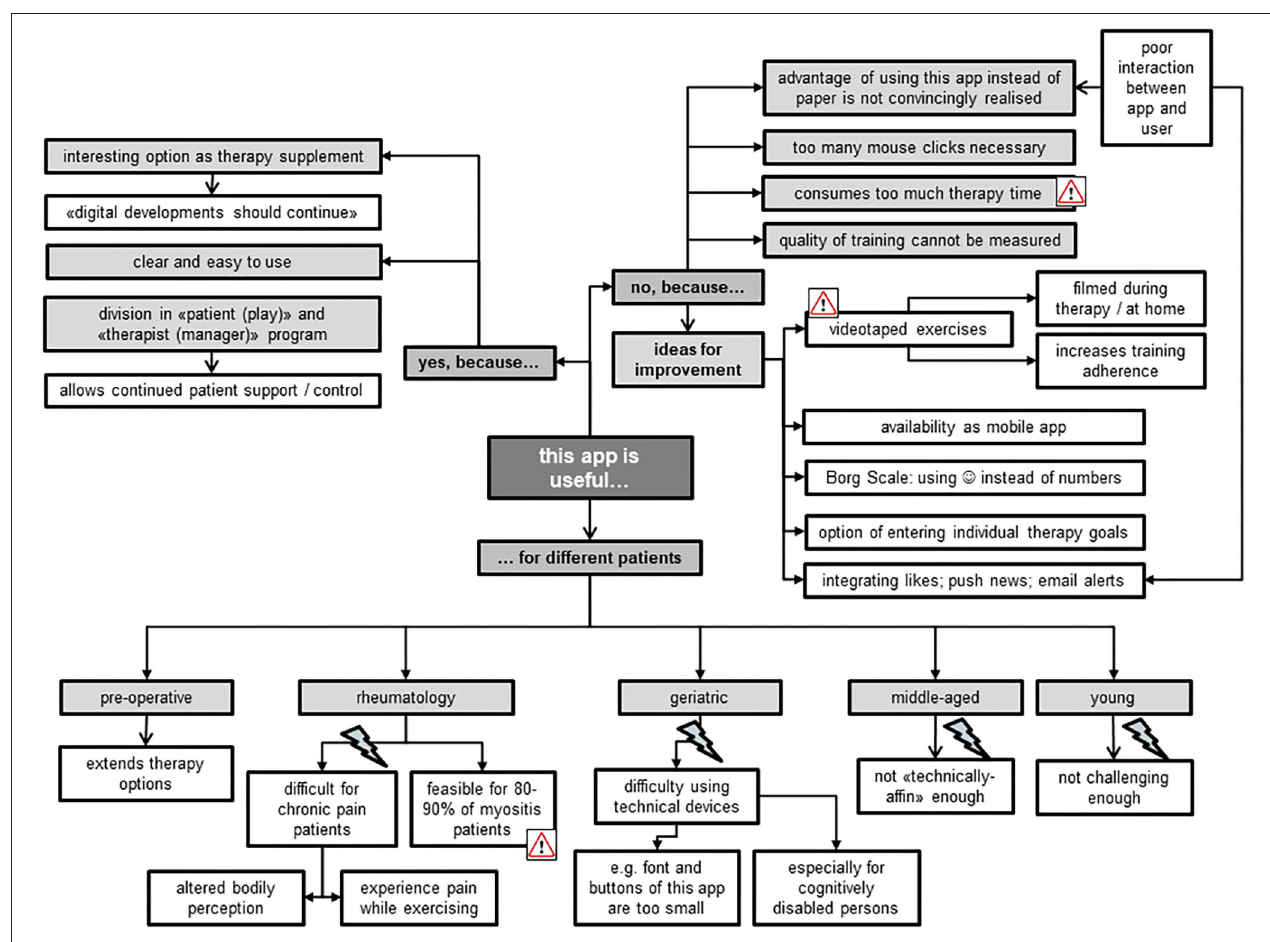
FIGURE 5 | Therapists’ perceived usefulness of the Fit app for daily work.